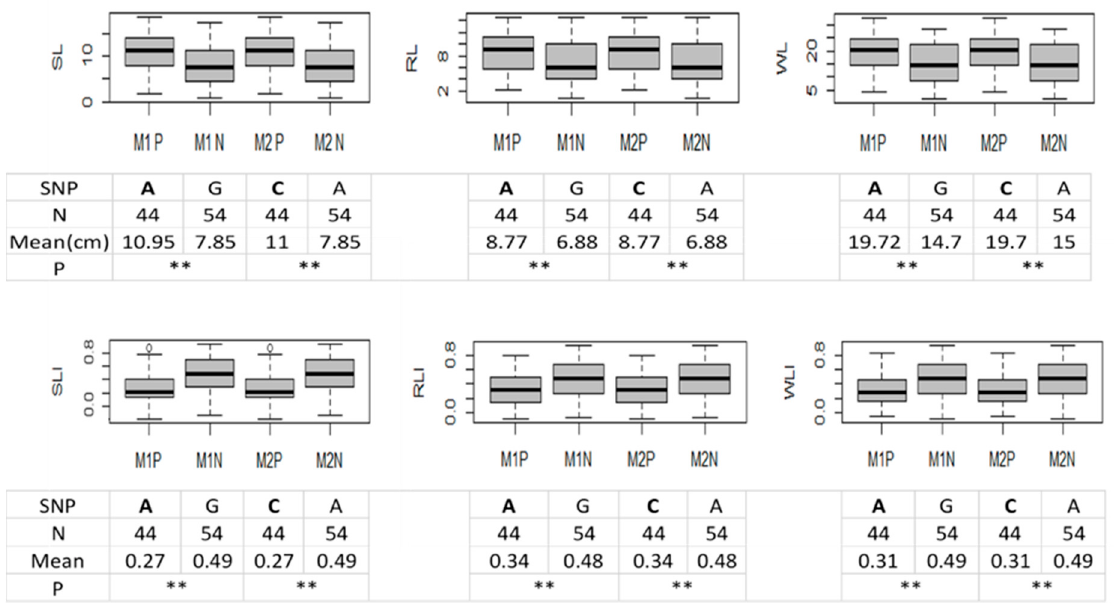
Figure 3. Match of SNPs with phenotype. SL, RL, WL indicate shoot length, root length, and whole plant length under 35°C heat stress condition, respectively. SLI, RLI, and WLI indicate damage in-dices of shoot length, root length, and whole plant length, respectively. M1P and M2P indicate groups with positive alleles of marker1 and 2; M1N and M2N indicate groups with negative alleles of marker 1 and 2. SNP indicates the polymorphism allele. N indicates number of lines in the group. Totally, 339 individual plants (2 parents and 111 ITMI lines with 3 replications for each genotype) were grown and used for data collection. Only the lines with homozygotes were counted for phenotypic validation. p shows significant difference in phenotype between the groups with positive allele and negative allele. ** = significant at p ≤ 0.01. Polymorphic allele (positive allele followed by negative allele) and phenotype data analysis were below corresponding box plot for length traits and DIs. Two sample t-test assuming equal variance was used to detect statistical